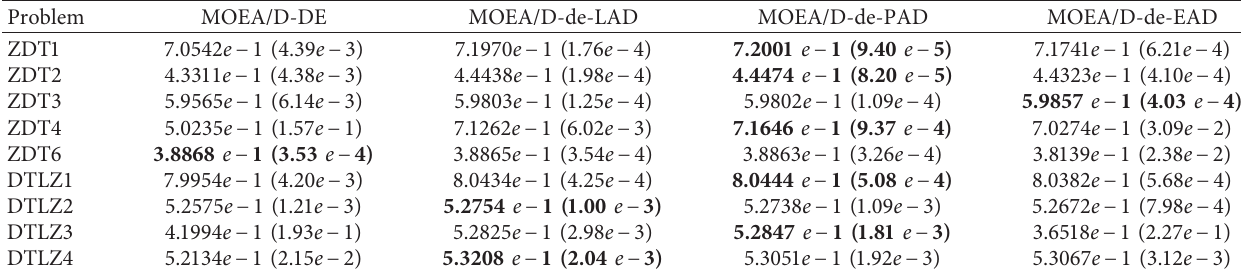
Table 3: HV metric (mean/std) results.